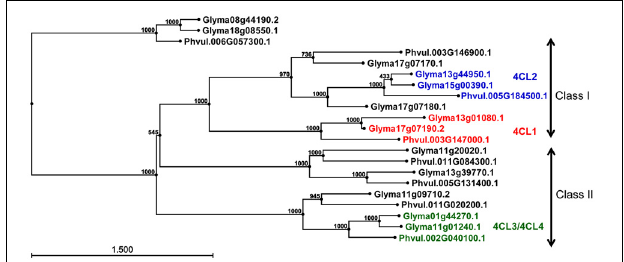
FIGURE 3 | Phylogenetic analysis of 4CL genes in common bean and soybean. Phylogenetic tree was constructed from 4CL genomic sequences using Neigbor Joining (NJ) algorithm and 1000 bootstrap replications in CLC Genomics Workbench 3. Scale represents genetic distance and node numbers indicate bootstrap support